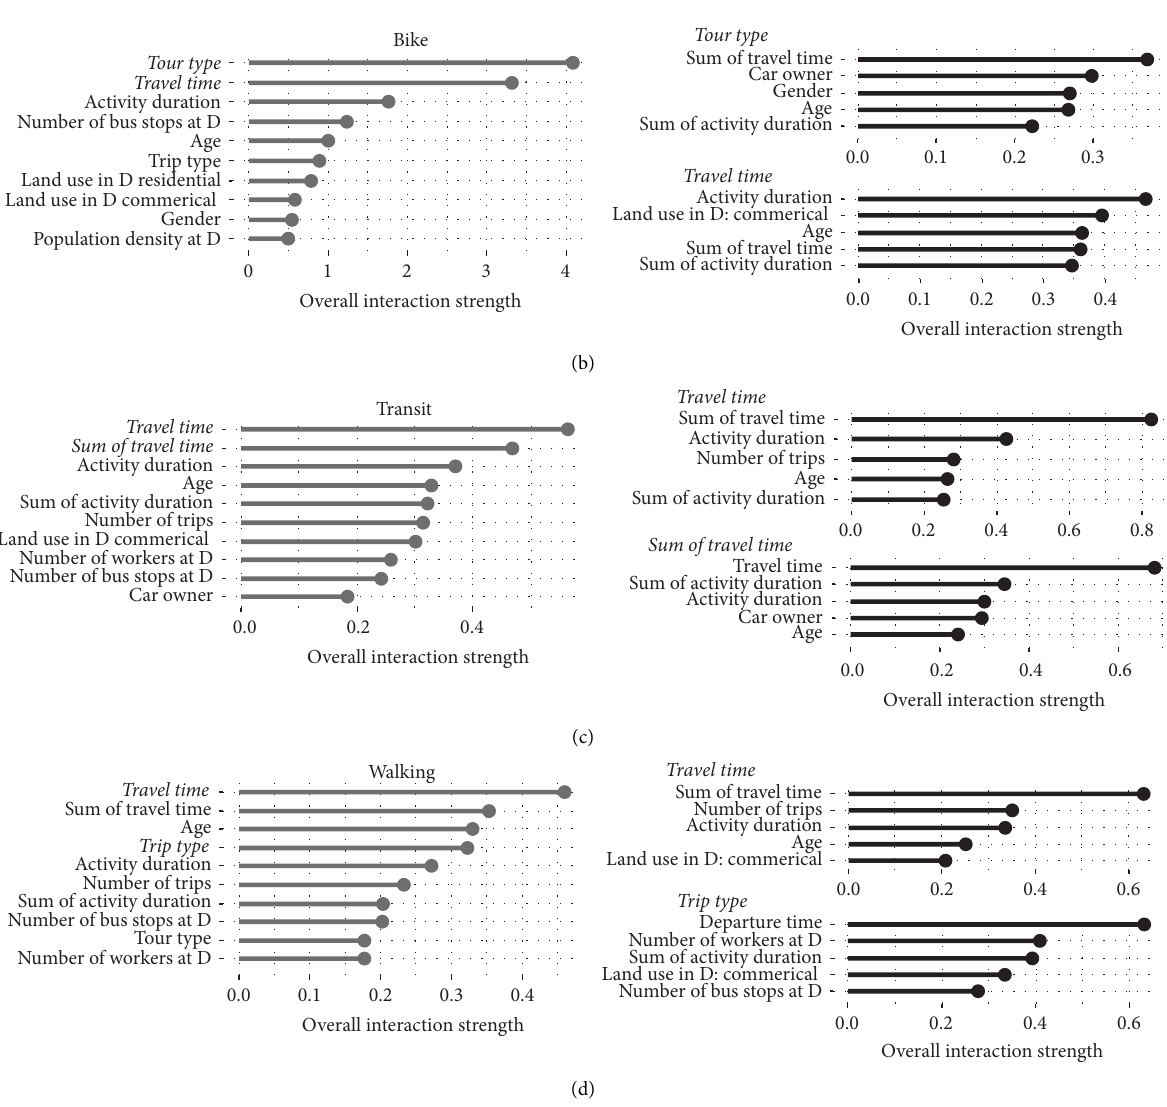
Figure 2: Variable interactions between one and other variables and between two variables, in predicting travel mode choice of (a) car, (b) bike, (c) transit, and (d)